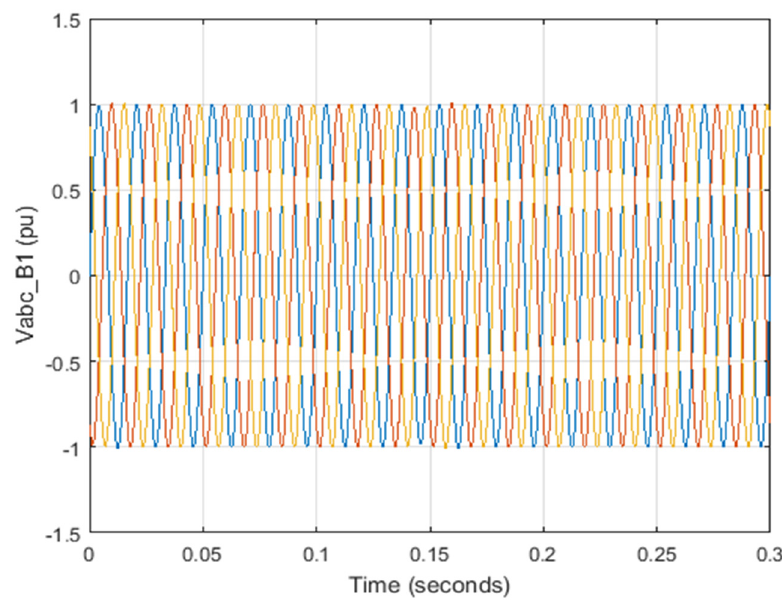
Figure 20. Grid and microgrid voltage common point.